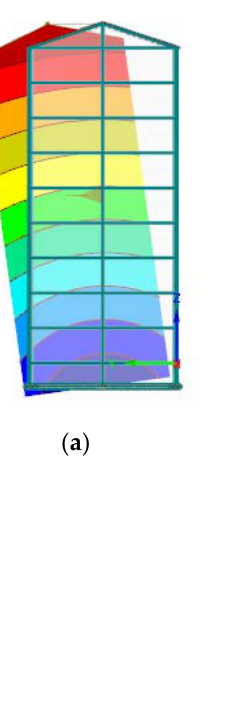
Table 7 analyzes the variation of rocking frequencies with soil type for buildings on shallow